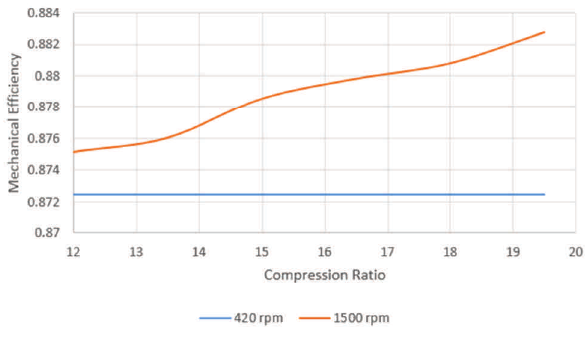
Fig. 6f. Graph of mechanical efficiency against compression ratio For the 420 rpm simulation, an indicated power of